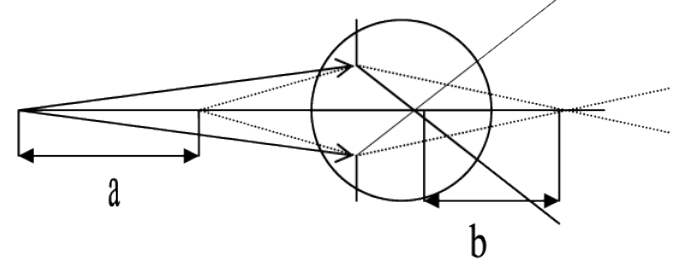
Figure 6. ( a ) Depth of field of the eye, ( b ) Depth of focus of the